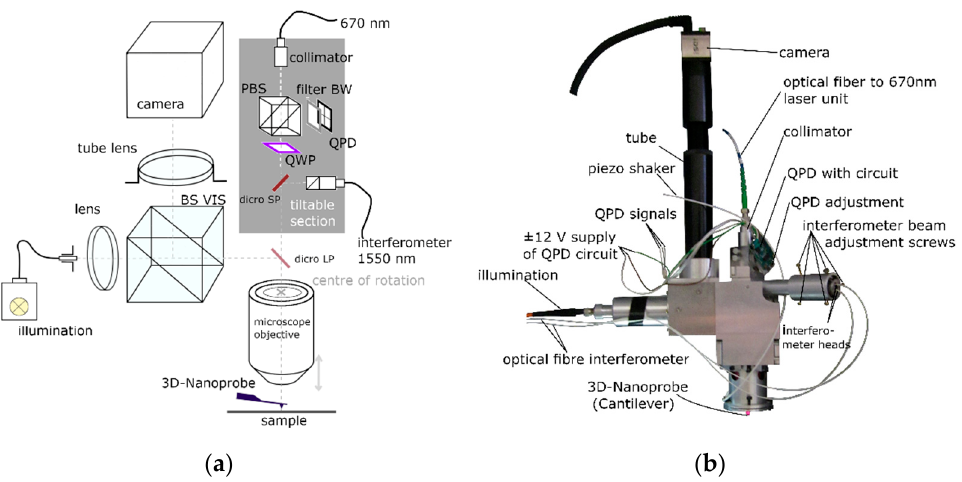
Figure 7. Schematic drawing of the true 3D-AFM-head ( a ) consisting of an optical microscope and a detection unit. Both share the same microscope objective. Image of the 3D-AFM-head ( b ).